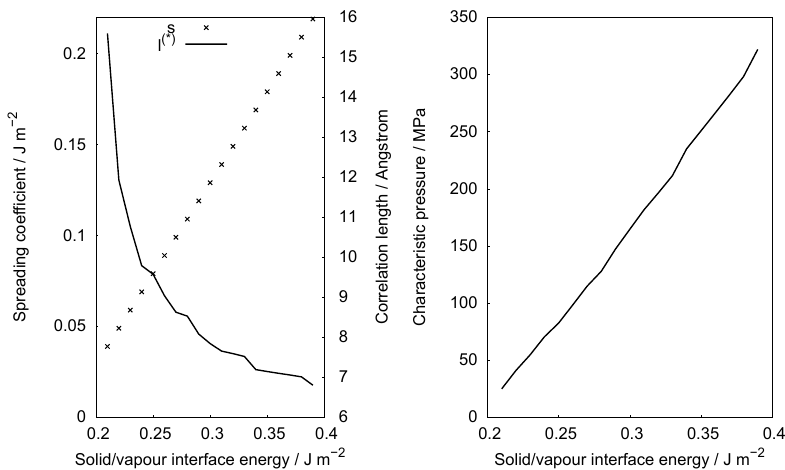
Figure 10. Calculated interfacial parameters as functions of σ (βγ) ∞ (with constraint s > 0). Left panel: spreading coefficient s and correlation length l ((cid:63)) . Right panel: characteristic disjoining pressure K ((cid:63)) = s/l ((cid:63)) .